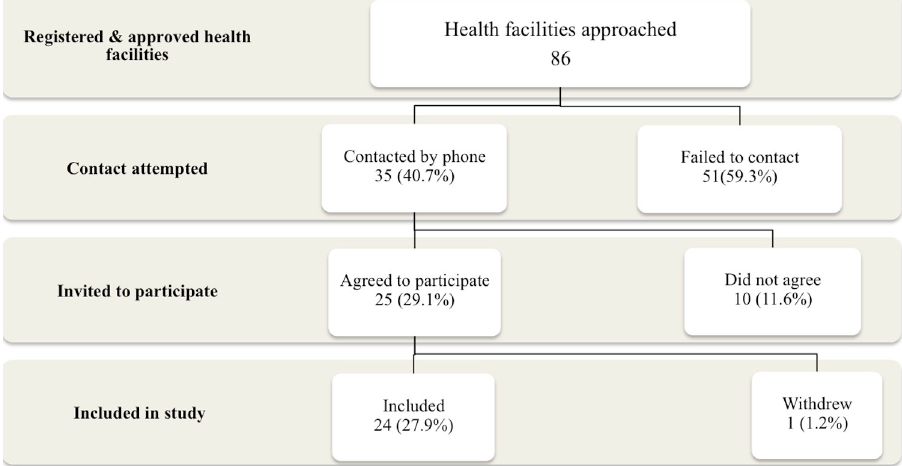
Fig 2. Flow diagram showing the process for identification and inclusion of health facilities in the